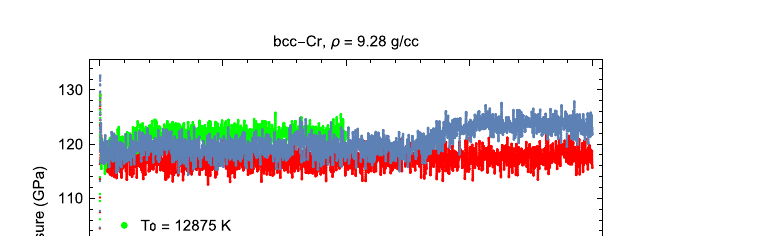
5500 K for the superheated state to ∼